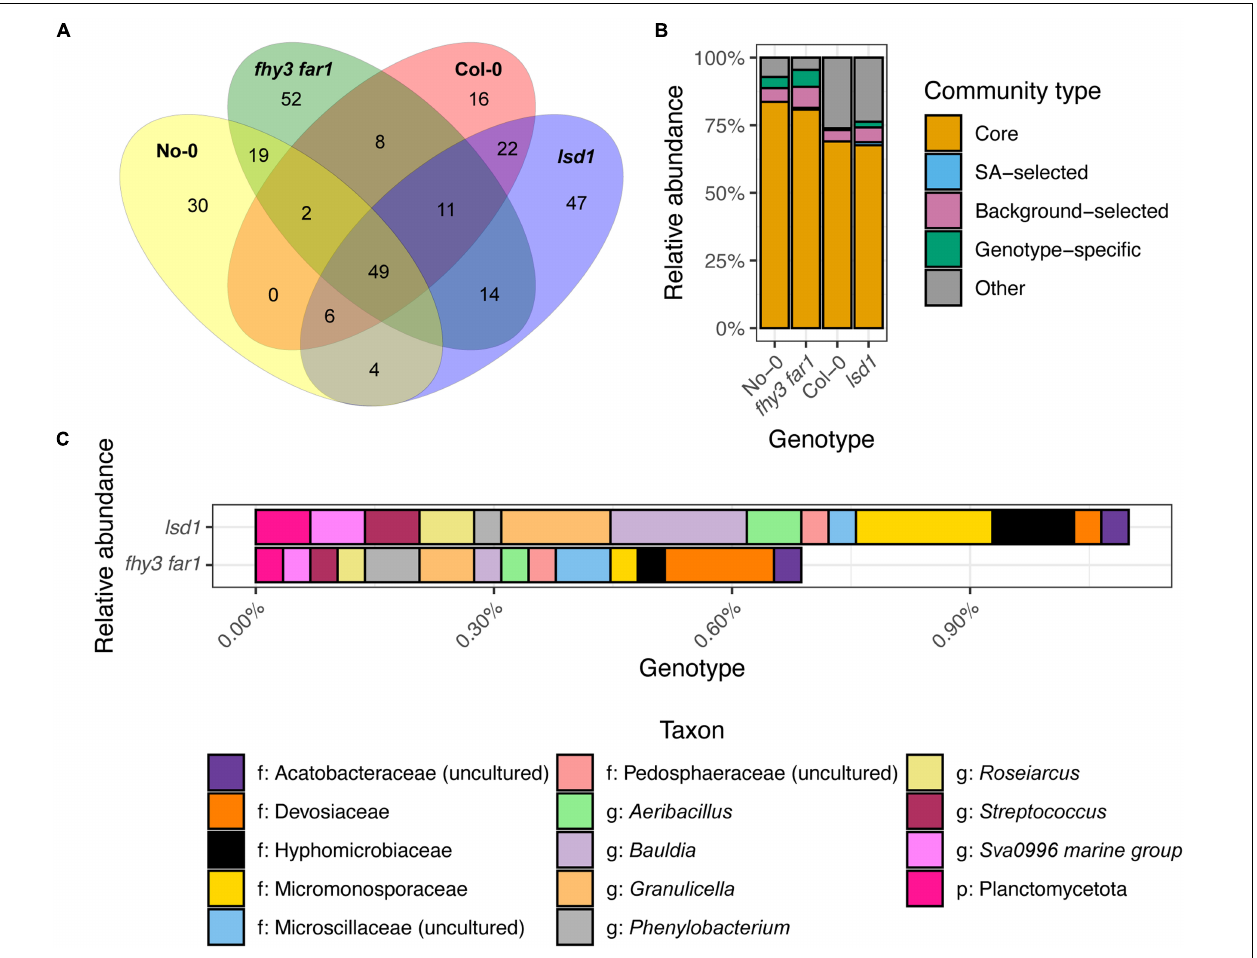
FIGURE 3 | Distribution of phyllospheric bacterial communities across wild type and salicylic acid signaling mutants. (A) Venn diagram showing the overlap of phylotypes across the two WT ecotypes and two SA signaling mutants, including the 49 “core” phylotypes present in all four genotypes; 14 “SA-selected” phylotypes present only in the SA signaling mutant phyllospheres; and unique phylotypes in each genotype phyllosphere. Phylotypes were identified using mothur (v.1.44.3) (Schloss et al., 2009) from bacterial 16S rRNA sequences present in the phyllosphere microbiomes of four A. thaliana genotypes 35 DAS. Samples were subsampled down to the size of the sample with the lowest number of sequences before plotting. Phylotypes classified to at least the phylum level were selected for consideration. (B) Relative abundances of the core, SA-selected and unique communities across all four genotypes. (C) Relative abundances of the 14 SA-selected phylotypes in lsd1 and fhy3 far1